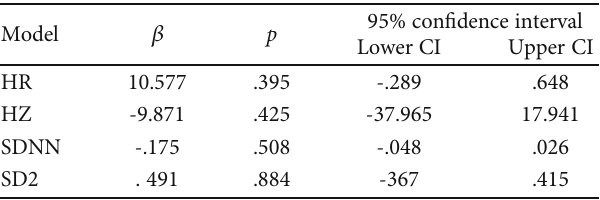
Table 4: Simple linear regression analysis between visual acuity and di ff erent HRV domains.